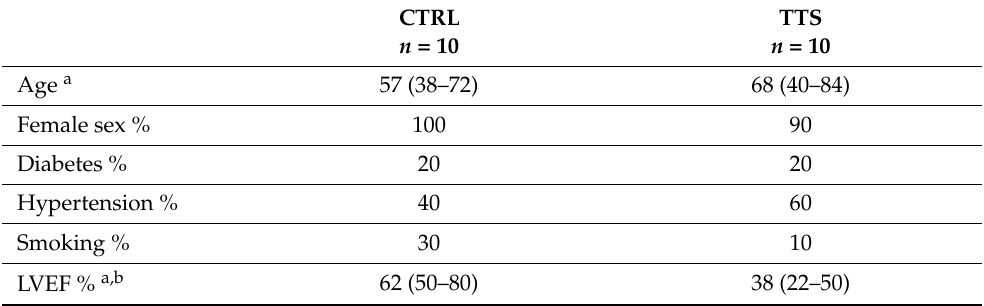
Table 1. Baseline characteristics of control and Takotsubo